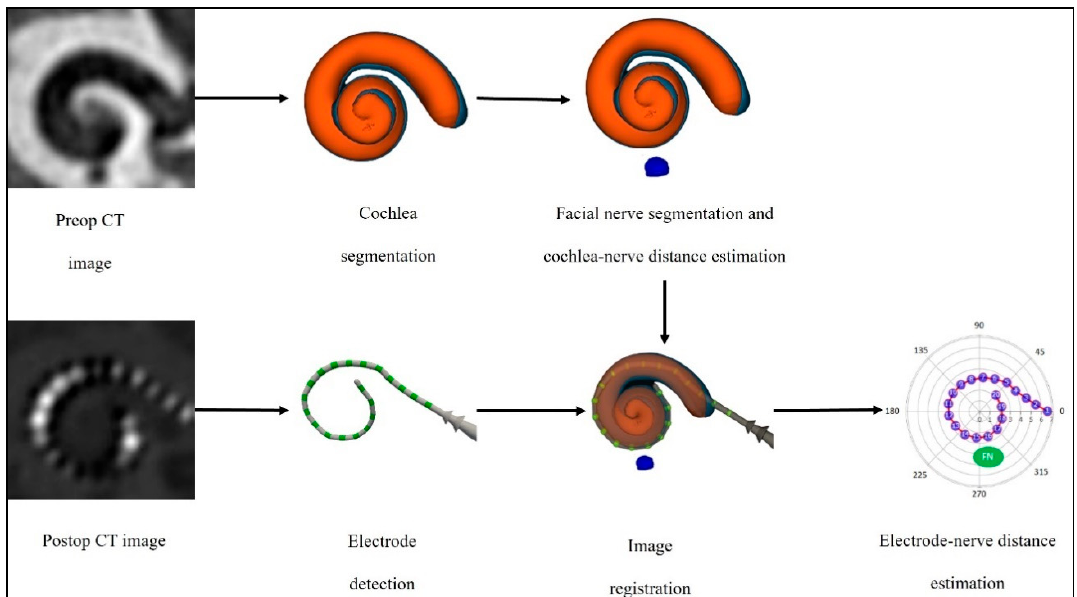
Figure 2. Model of CT image reconstruction performed by the software Nautilus in this study: cochlear segmentation, angular positioning of the electrodes and cochlear-nerve and electrode-nerve distances estimation.